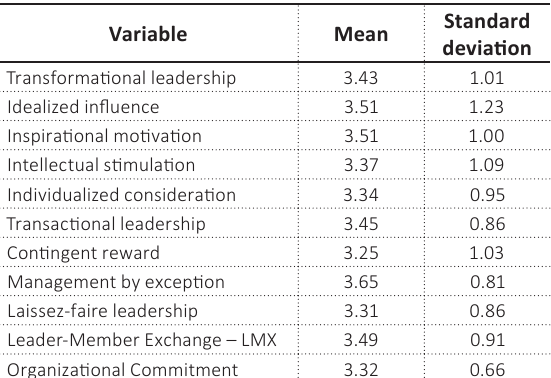
Table 2. Means and standard deviations